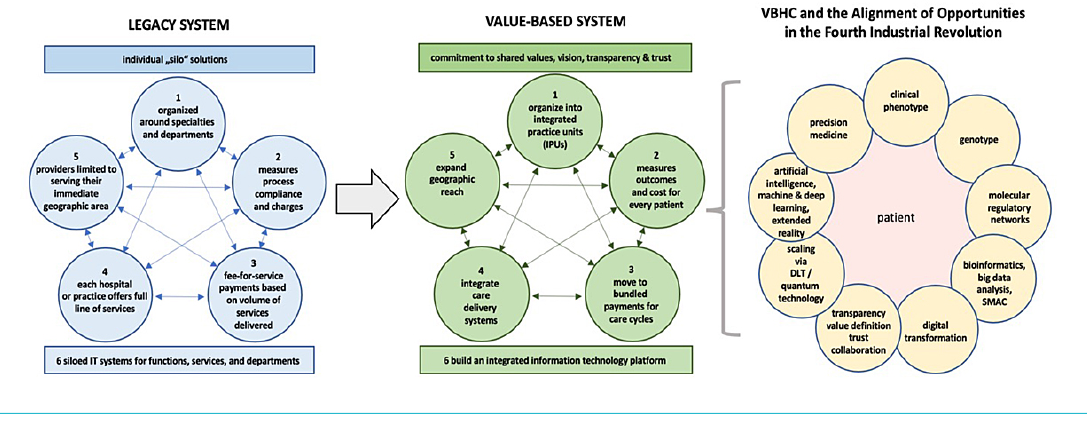
Figure 1: The legacy system evolved over decades and is based on individual silo solutions of single institutions without exchange. The value- based system builds on shared commitment to defining and assessing quality and outcome using a shared information technology platform. Such an integrated system will prepare our health system to meet the opportunities of the fourth industrial revolution.